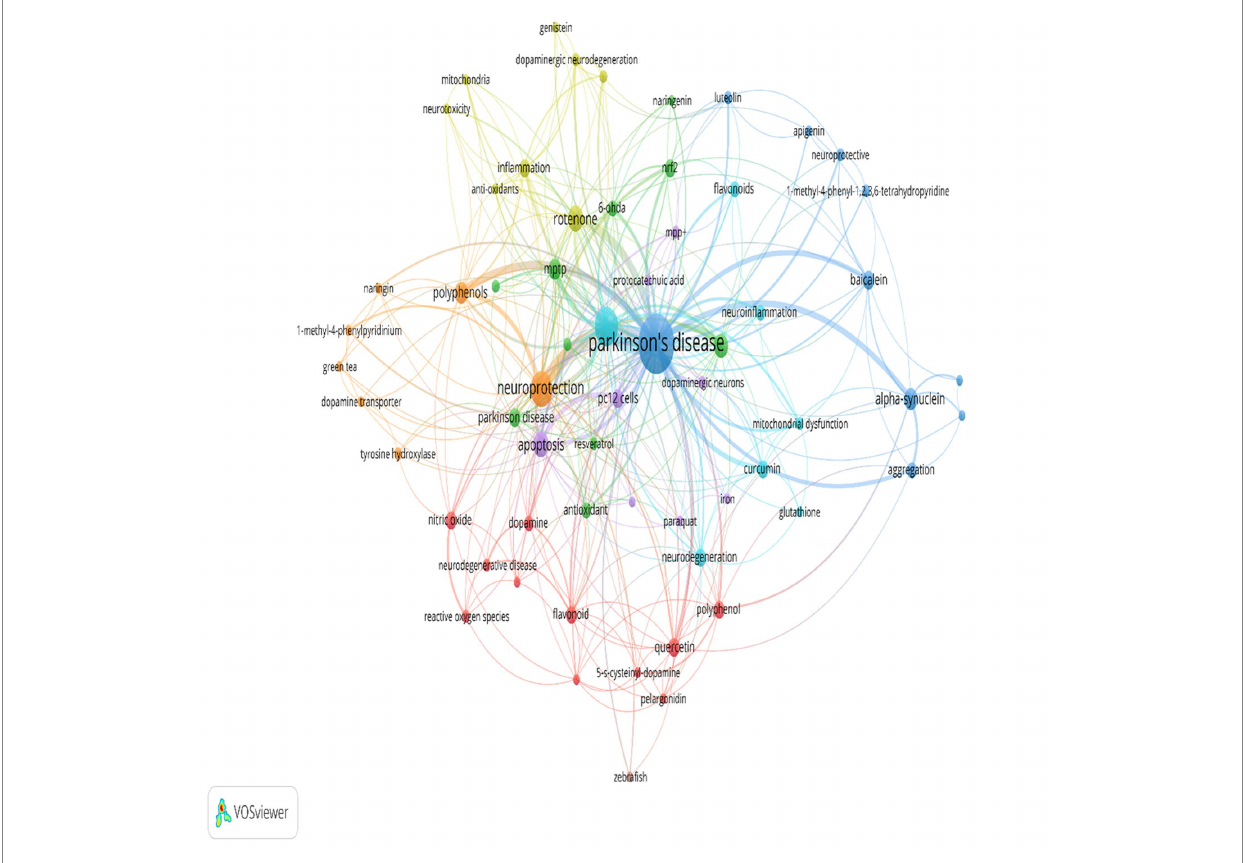
FIGURE 5 Author keyword network analysis with 2 or more occurrences. The node size represents the frequency of the author keyword with larger nodes indicating greater frequency. The color of the node represents the possibility of co-occurrence of author keywords among the 100 most cited articles on PD and PC with nodes of the same color demonstrating that there is co-occurrence between author keywords in the same article. The thickness of the line between nodes represents the strength of linkage between author keywords with strong linkage strengths being demonstrated by thicker lines. More frequent author keywords have stronger linking